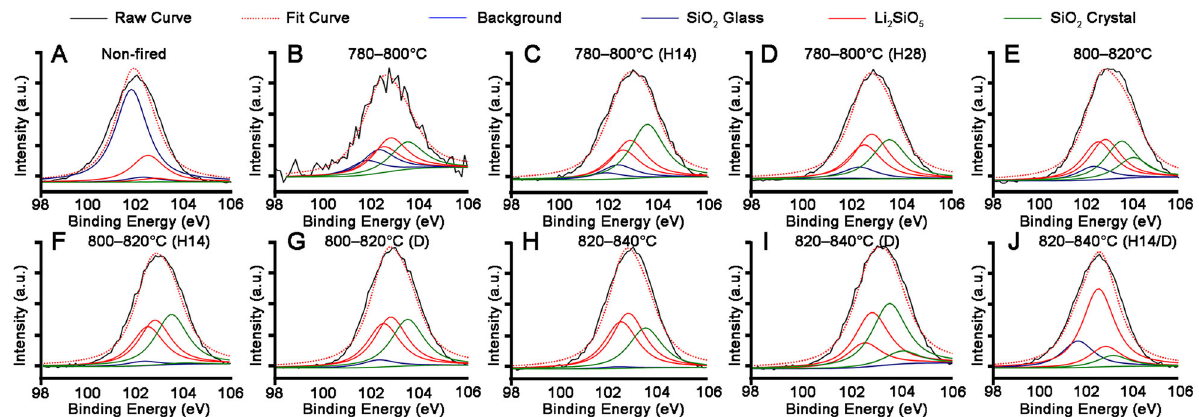
Fig. 2 XPS showing high-resolution peaks for Si2p in LDGC materials heated under various thermal conditions. The details of deconvolution are listed in Table